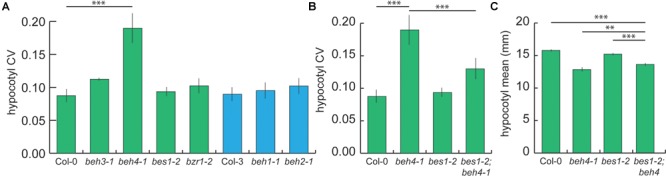
beh4-1 decreases robustness of dark grown hypocotyls | (A) The beh4-1 mutant exhibits significantly greater variation in hypocotyl length compared to wild-type (∗∗∗p < 0.0001, Levene’s test, n = 210). None of the other single mutants increase hypocotyl length variance significantly. (B) The double mutant bes1-2;beh4-1 showed an intermediate effect on hypocotyl length robustness compared to either single mutant (∗∗∗p < 0.0001, Levene’s test, n = 210). CV was estimated in three biological replicates. Standard error of the mean for n = 3 is shown for both (A) and (B). (C) The double mutant bes1-2;beh4-1 also showed an intermediate effect on hypocotyl mean values compared to either single mutant (∗∗∗p < 0.0001, ∗∗p < 0.001, linear mixed effects model with genotype as a fixed effect and replicate as a random effect).